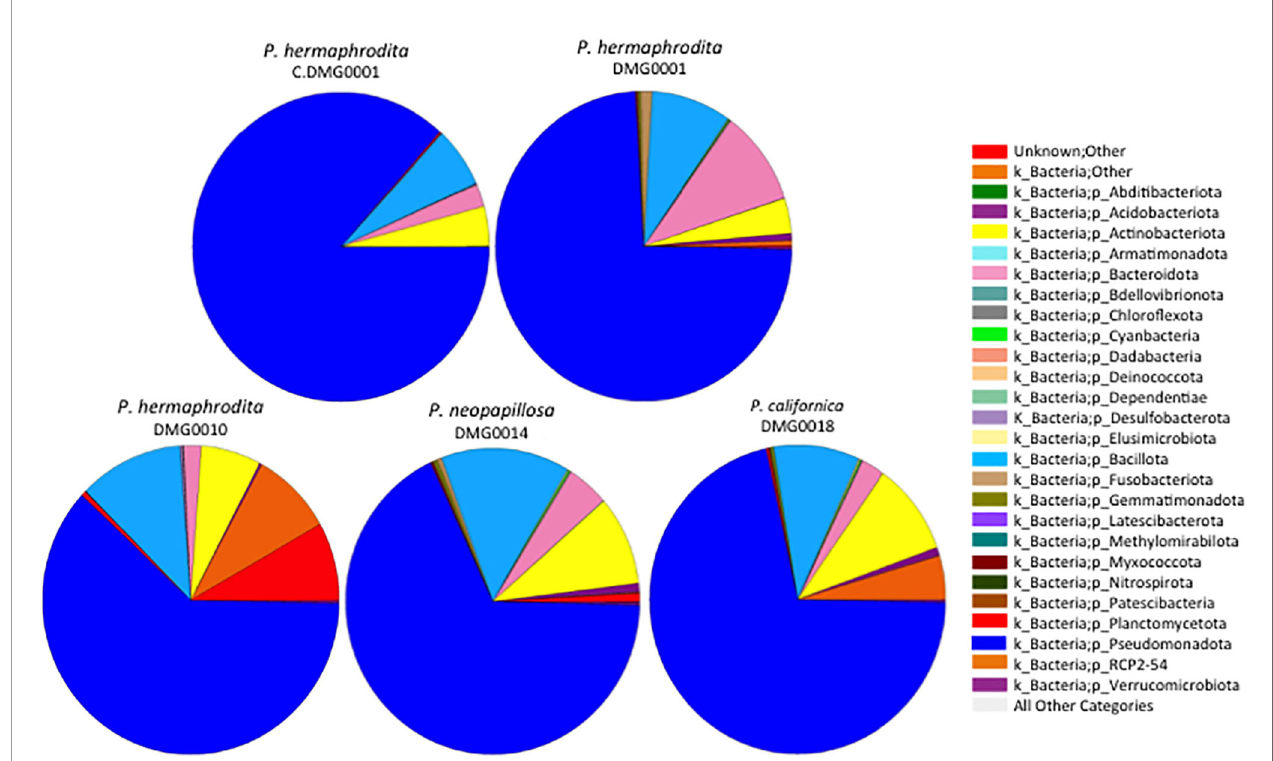
FIGURE 3 | The diversity of bacteria malacopathogenic nematodes associate with: P. hermaphrodita (C.DMG0001, DMG0001, DMG0010), P. californica (DMG0018) and P. neopapillosa (DMG0014). Higher diversity is present in samples which killed a slug host (DMG0001, DMG0010, DMG0014 and DMG0018) whilst the control sample C.DMG0001 has the lowest diversity.